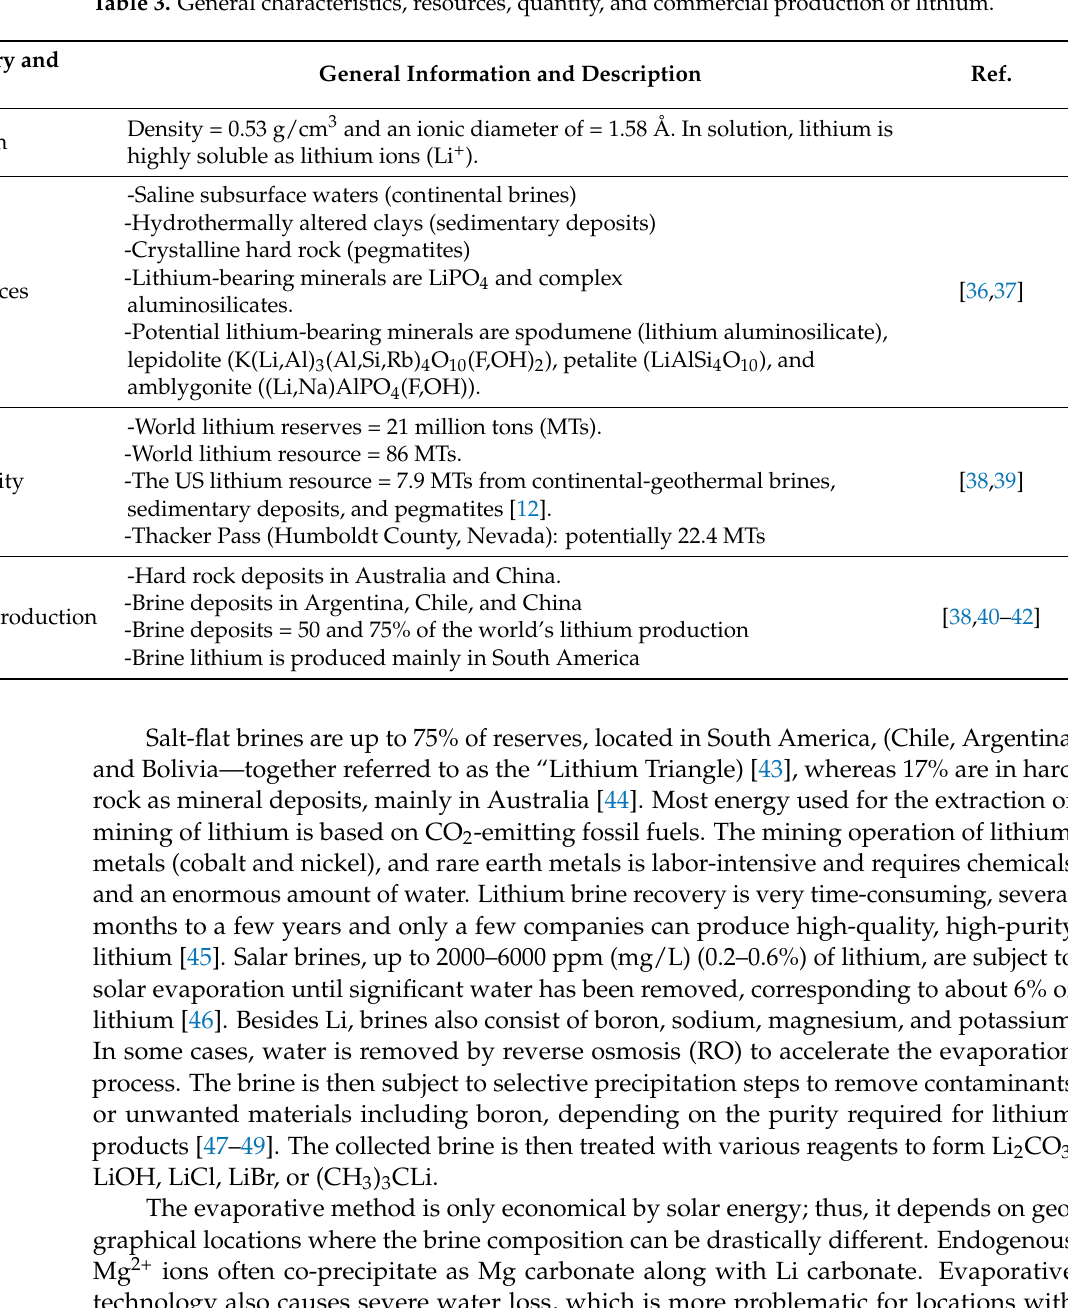
Table 3. General characteristics, resources, quantity, and commercial production of